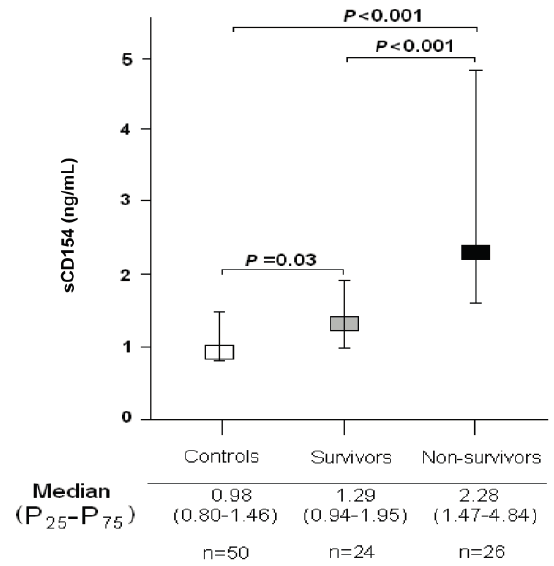
Figure 1. Serum sCD154 levels in severe malignant middle cerebral artery infarction patients and healthy